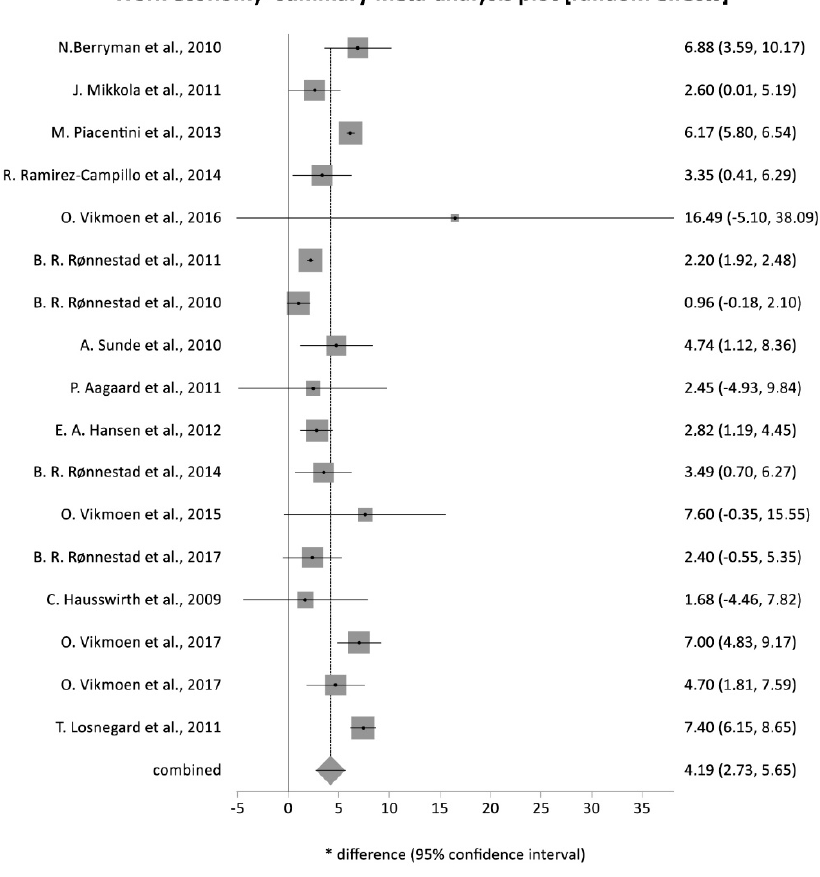
Figure 2. Forest plot of the studies included in the meta-analysis for work economy: forest plot with effects size and 95% confidence interval of every study included in the statistical analysis and combined effect size, representing the effect of intervention protocol (non-sport-specific strength training) on the economy of gesture (work economy). Cochran Q = 352.5 (df = 16) p < 0.0001; moment-based estimate of between studies variance = 6.6; I2 (inconsistency) = 95.5% (95% CI = 94.3% to 96.3%); random effects (Der Simonian–Laird); Pooled * difference = 4.19 (95% CI = 2.7 to 5.6); Z (test * Difference) = 5.6 p < 0.0001.